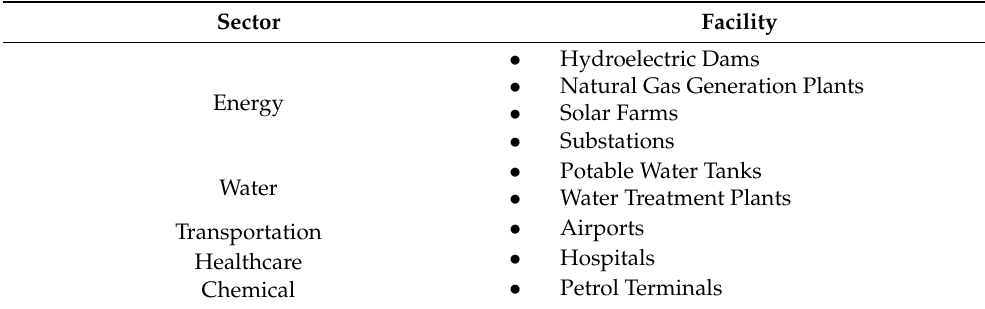
Table 1. Selected CI sectors and facilities for identification using proposed machine-learning model.